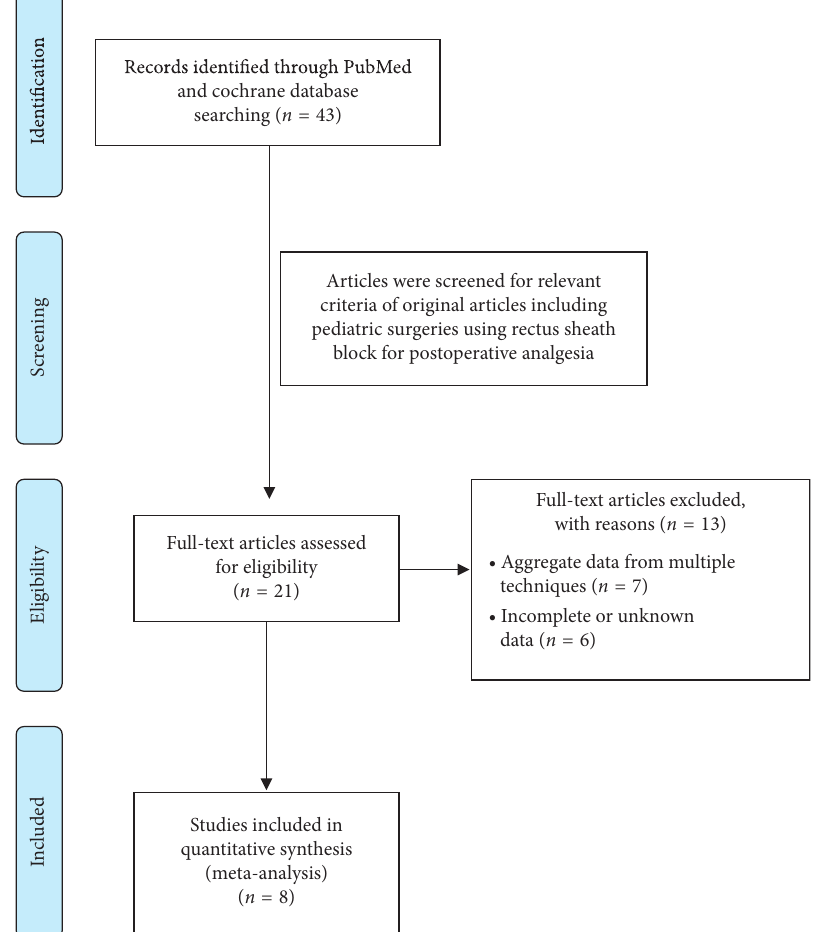
Figure 1: PRISMA flow diagram showing literature search and selection of studies in the